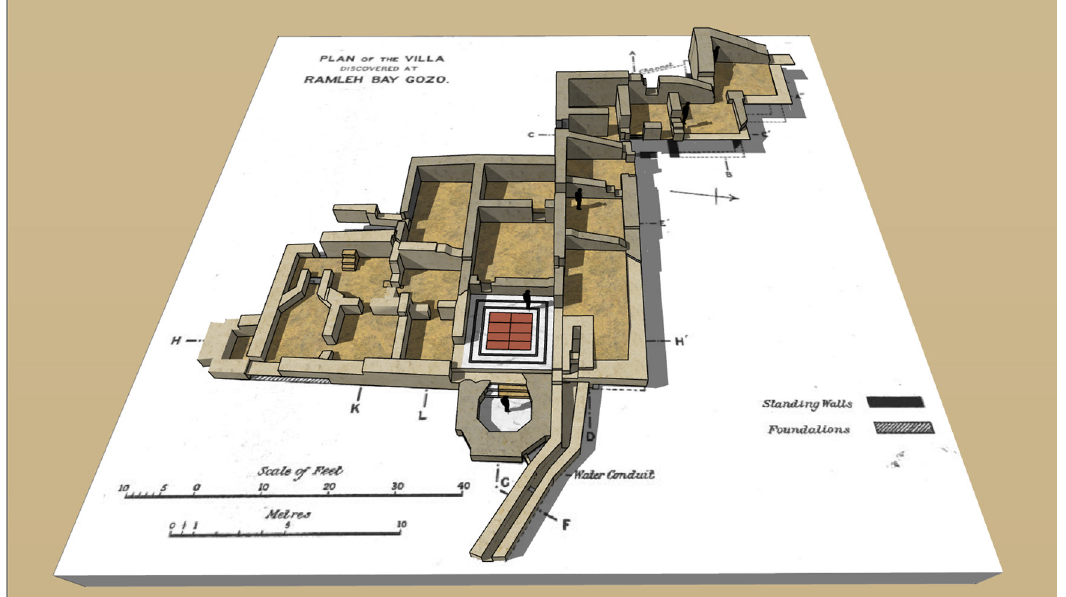
Figure 15: A 3D model reconstruction of the site representing the volumes and structures as documented in 1911. Reconstruction based on plan and sections published in Ashby, 1915 ( Source: Author )